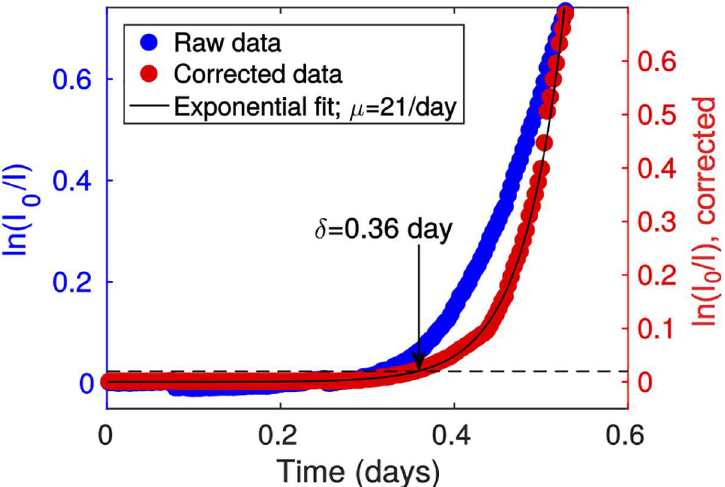
Fig 3. Exponential adjustment and derivation of growth parameters. A typical experimental curve showingmicroscopic absorbance (blue dots and left y axis) is representedtogether with the curve corrected by the microscopicabsorbance-concentrationrelationin S1 Fig (red dots and right y axis) and the exponential adjustment(black line) giving the growth rate μ . The lag time δ is definedas the time where the corrected absorbance hits 0.02 (dashedline).